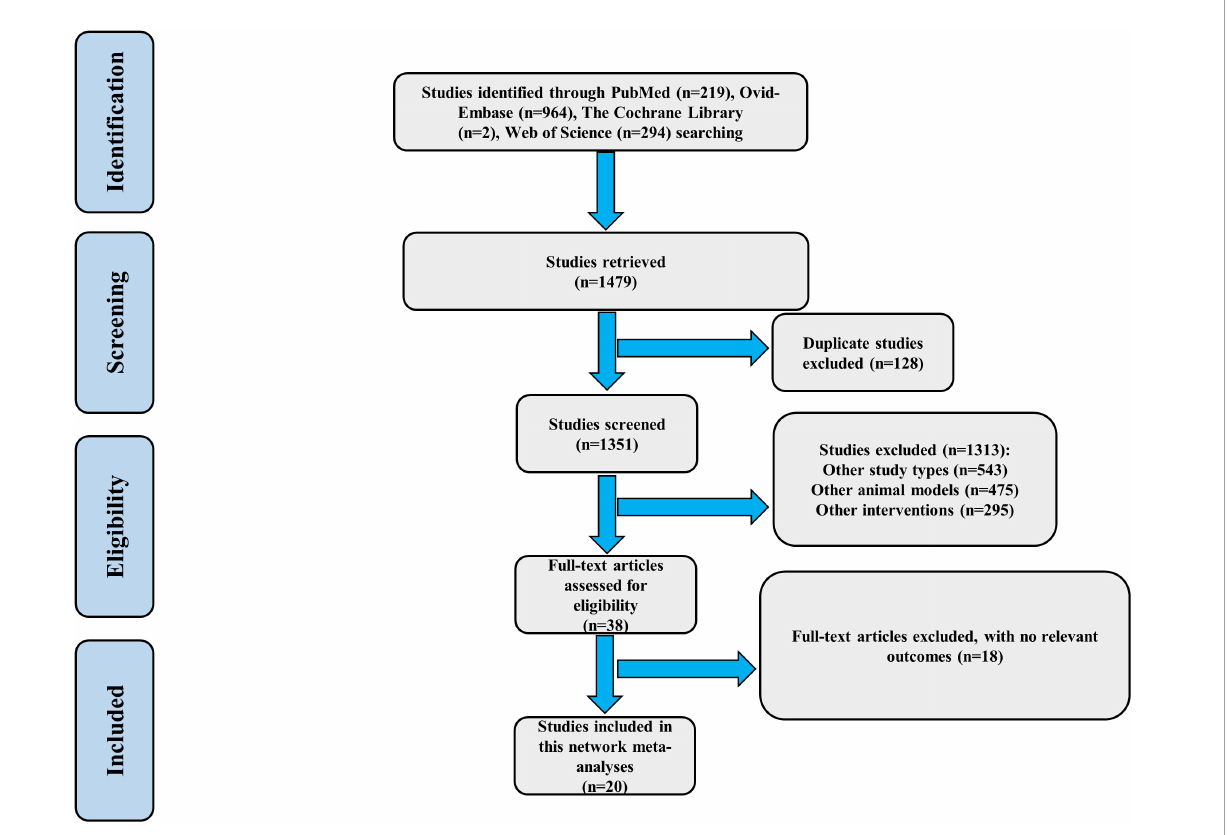
FIGURE1 Flow chart of screening